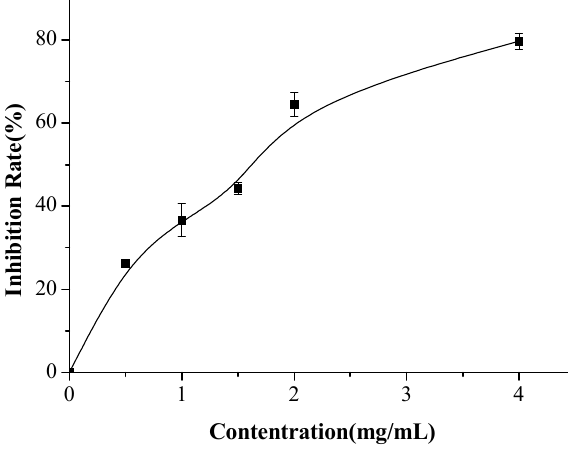
Figure 4. Anticoagulant activity IC50 of enzymatic hydrolysate from adductor muscle. Five different concentrations (0.5~4 mg/mL) were investigated, as measured by a microplate reader.